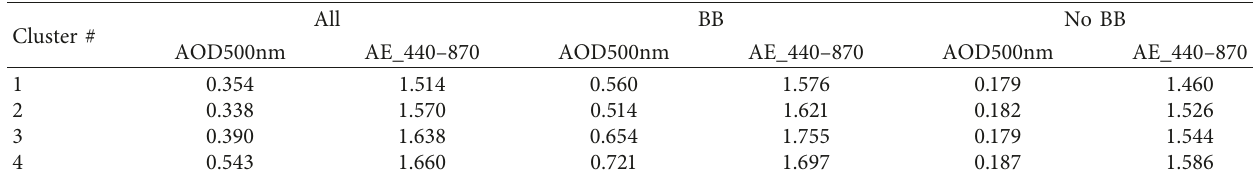
Figure 9: Composite wind fields for each cluster: wind ( vector ); wind speed ( shaded ) at 850hPa, and wind shear between 850 hPa and 700hPa ( red contours ). Shaded : wind intensity stronger than 12 m · s − 1 . Red contours : wind shear greater than 6m · s − 1 . Terrain elevations higher than 1500m are shown. Table 2: Mean AOD500nm and AE_440–870nm for each trajectory